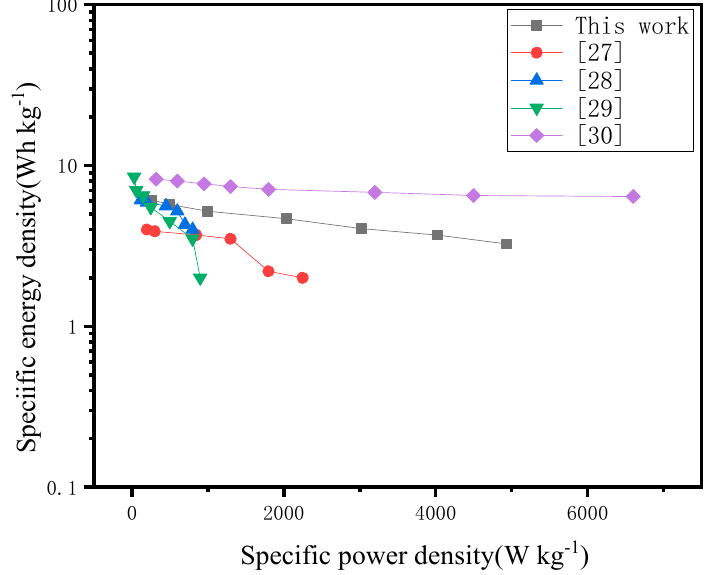
Figure 6. Ragone plot related to energy and power densities of carbon supercapacitor.